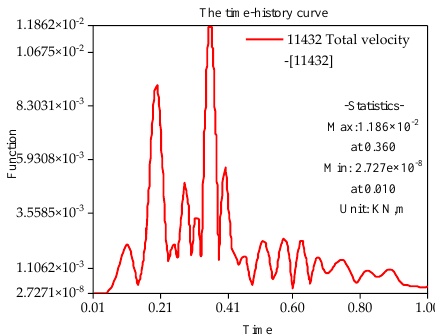
Figure 11. Total vibration curve on the basement of perilous rock.